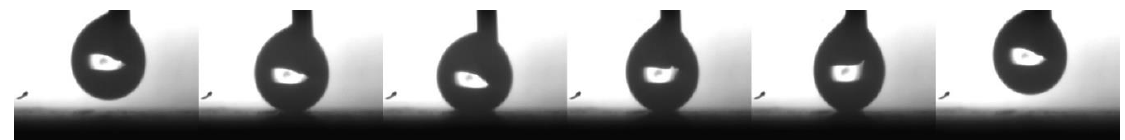
Figure 3. Contact angle measurement on the PS-nanoF-2 sample: from left to right, the pendant water drop touches the stone sample, the droplet does not stick onto the treated surface but remains attached to the needle.